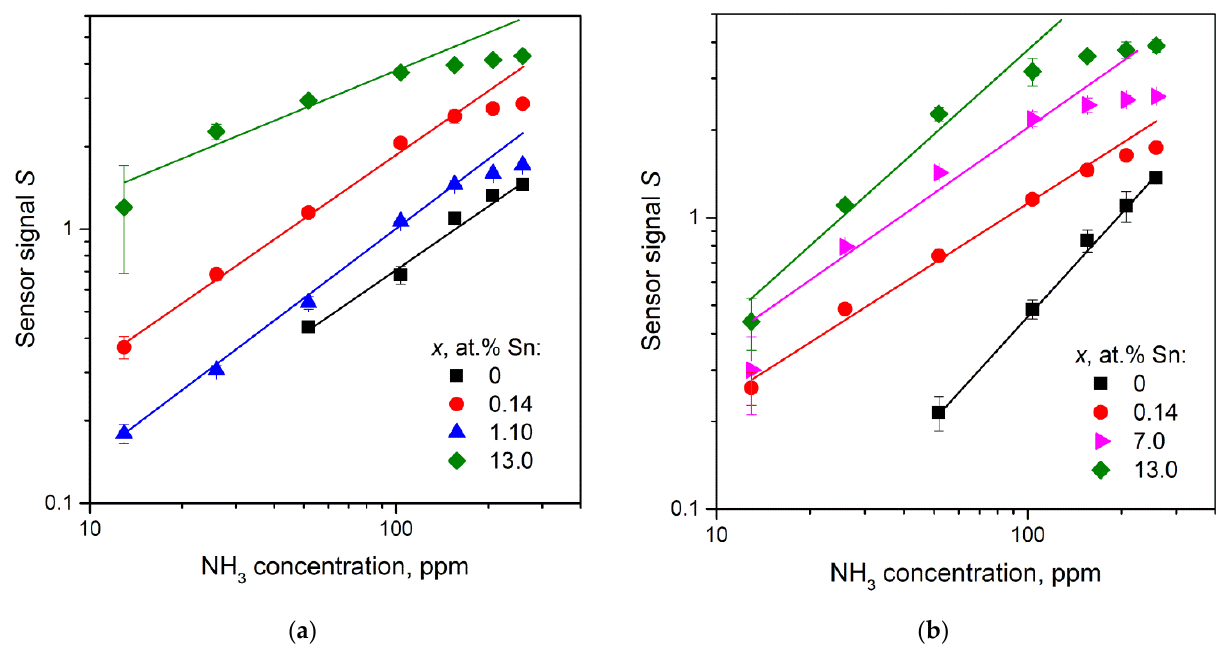
Figure 15. Sensor signal S as a function of NH 3 concentration for Ga 2 O 3 (Sn) samples annealed at 750 ( a ) and 1000 °C ( b ). The measuring temperature is 500 °C.